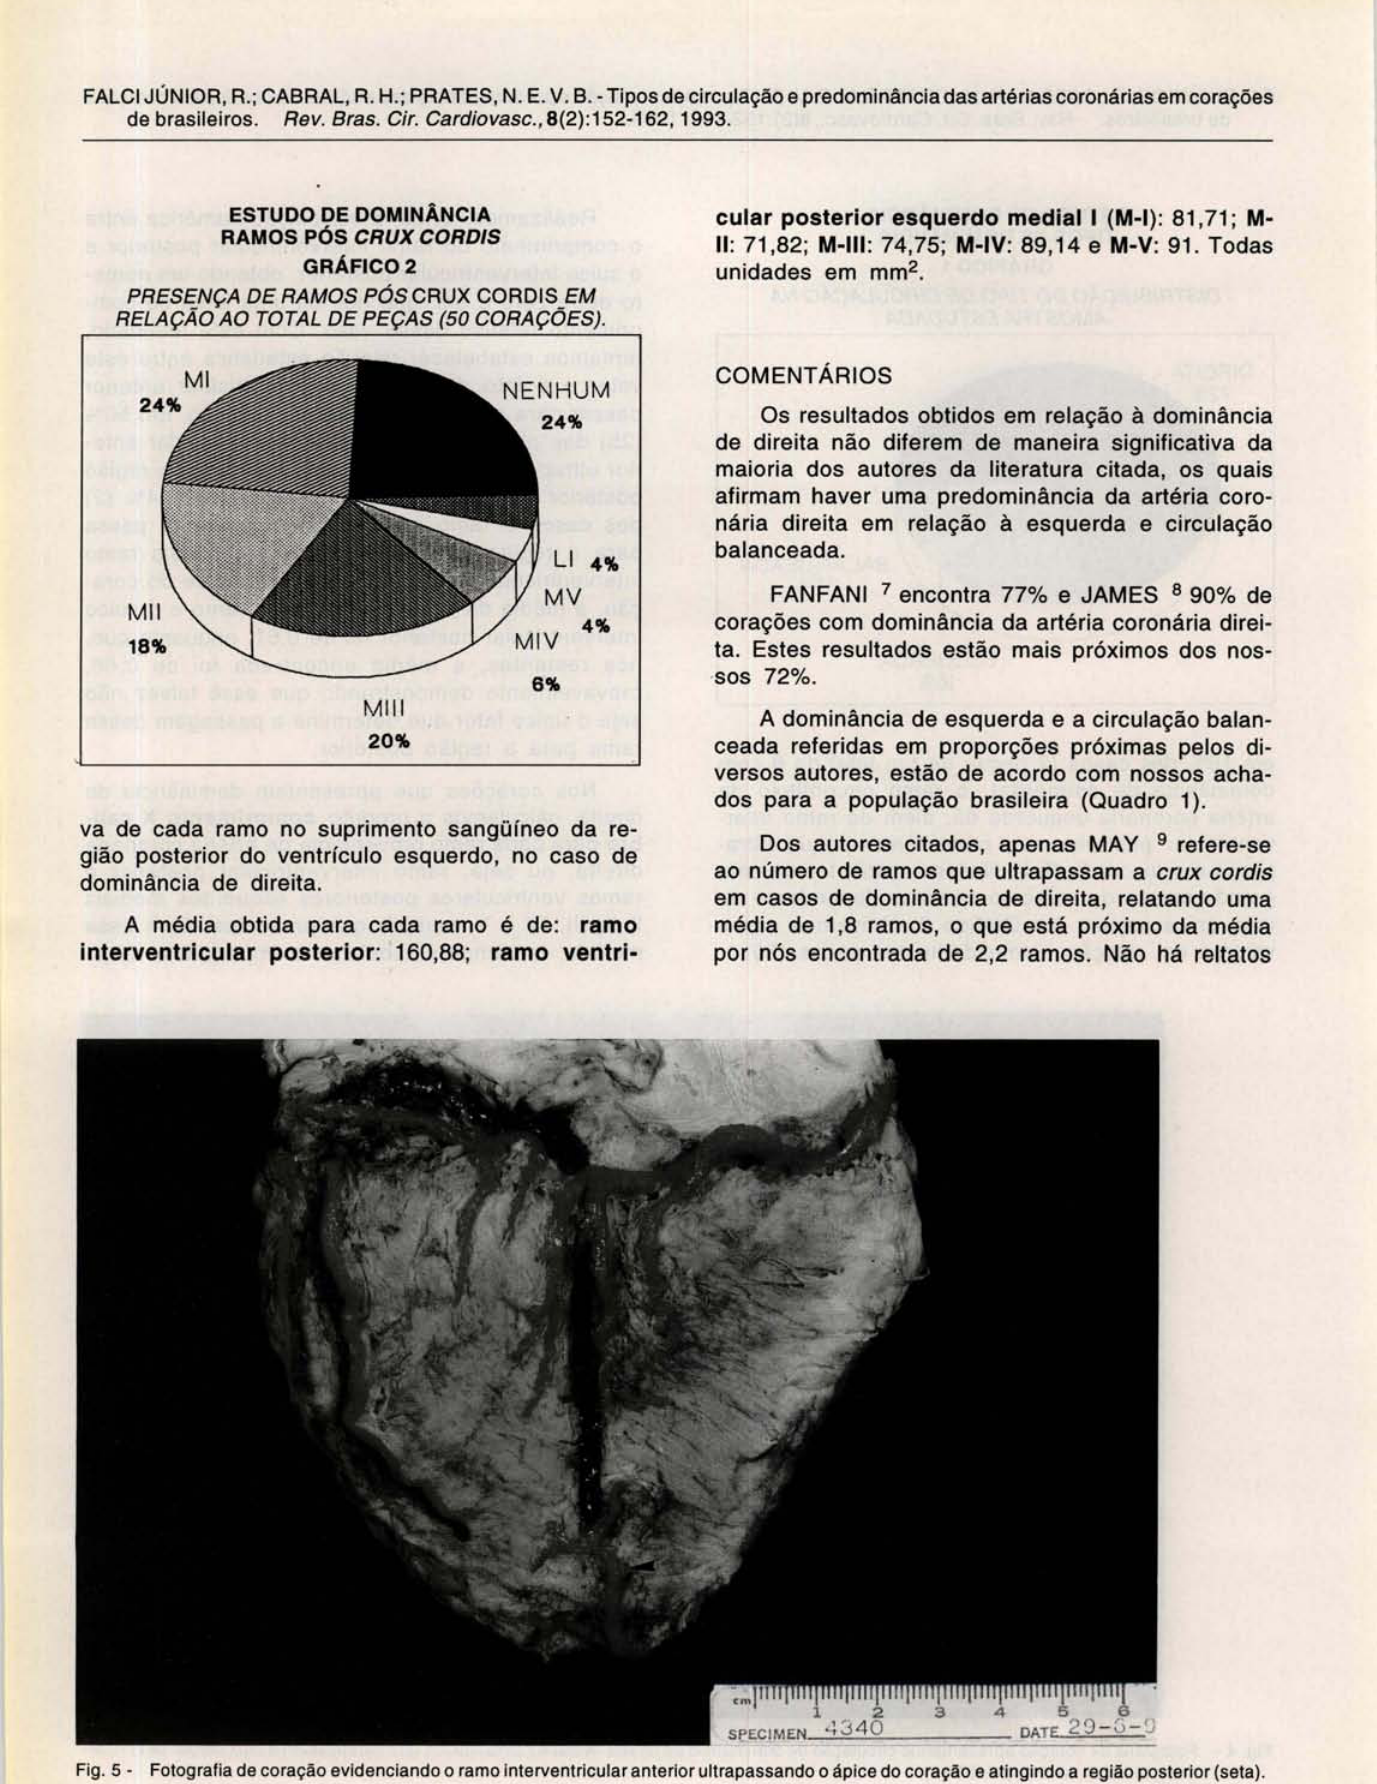
Fig. 5 - Fotografia de coração evidenciando o ramo interventricular anterior ultrapassando o ápice do coração e atingindo a região posterior